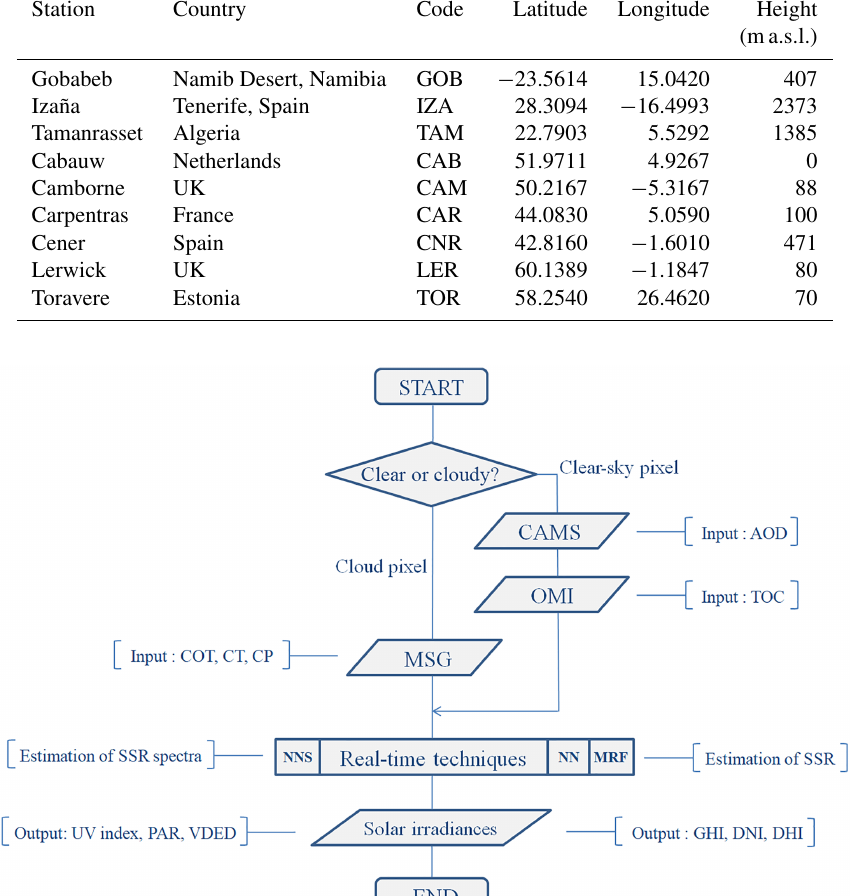
Figure 1. Flowchart of the modelling technique scheme. The initial pixel classification followed by the clear- or cloudy-sky inputs to the real-time solver result the spectral (NNS) and integrated (MRF and NN) SSR-related